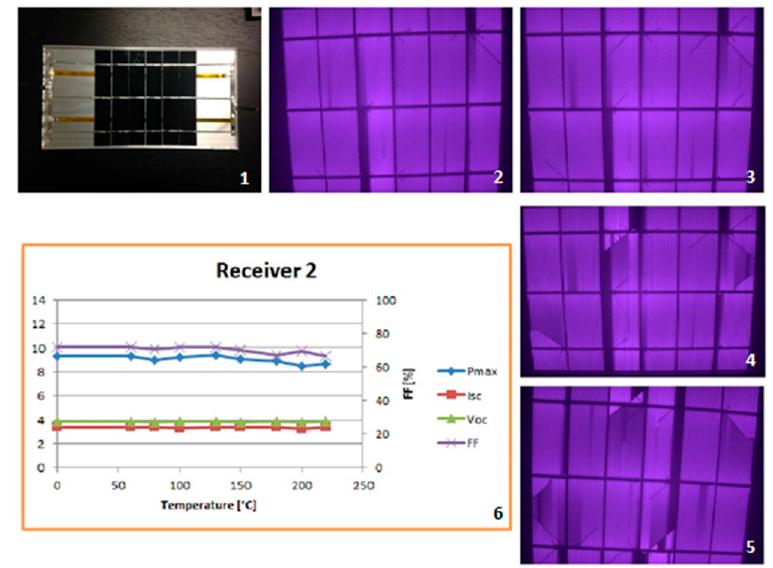
Figure 10. ( 1 ) Receiver 2; ( 2 ) Baseline Round; ( 3 ) Round 5 (150 °C); ( 4 ) Round 6 (180 °C); ( 5 ) Round 8 (220 °C); ( 6 ) Parameters of the IV curve at different temperatures (Isc, Voc and Pmax shown in the left Y axis and FF in the right Y axis).